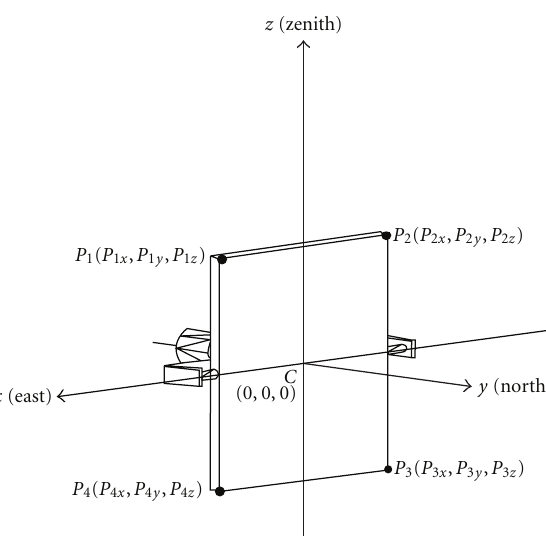
Figure 2: The initial coordinate of the heliostat frame is first defined in a fixed coordinate system. Where origin at the mid of the heliostat frame and P i is the point at the corner edge of the heliostat frame.